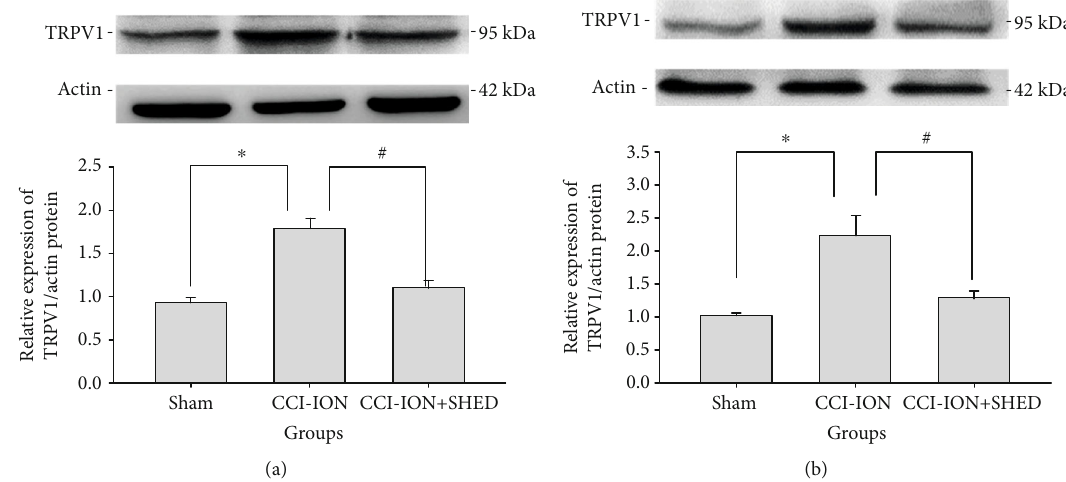
Figure 8: Local SHED transplantation suppresses upregulation of TRPV1 protein levels in CCI-ION rats. TRPV1 protein expression in the TG (a) and trigeminal nerve (b) of sham rats. All data are expressed as the mean ± SEM ( n = 6 rats in each